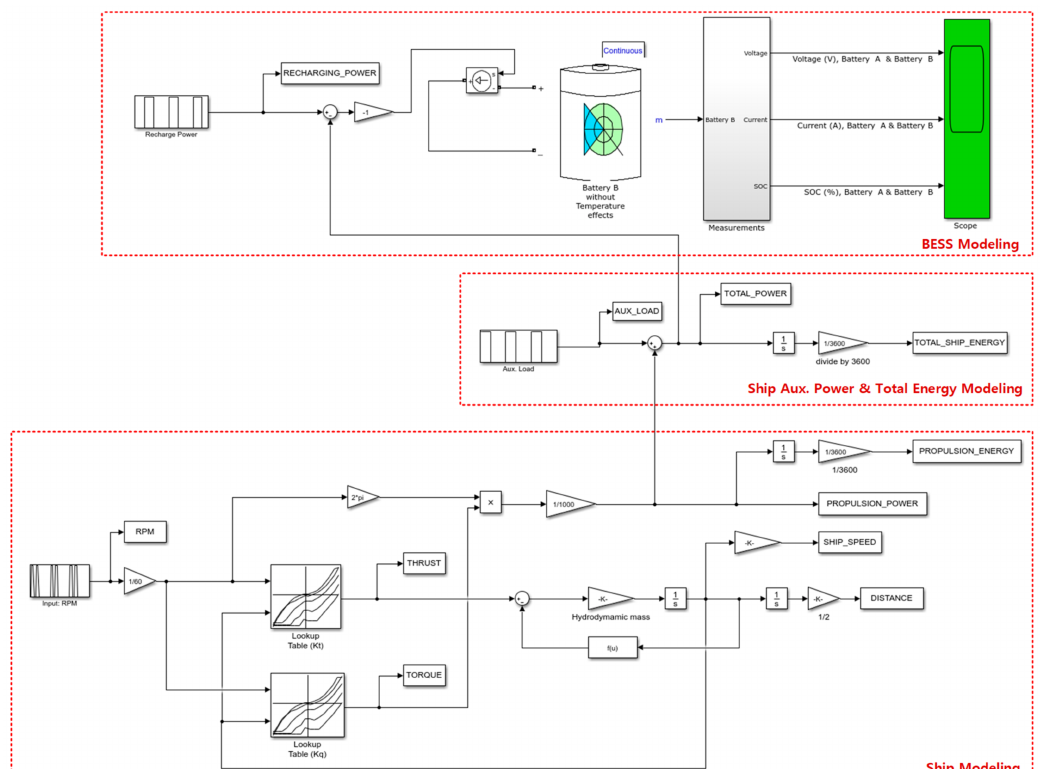
Figure 7. Simulation for BESS capacity